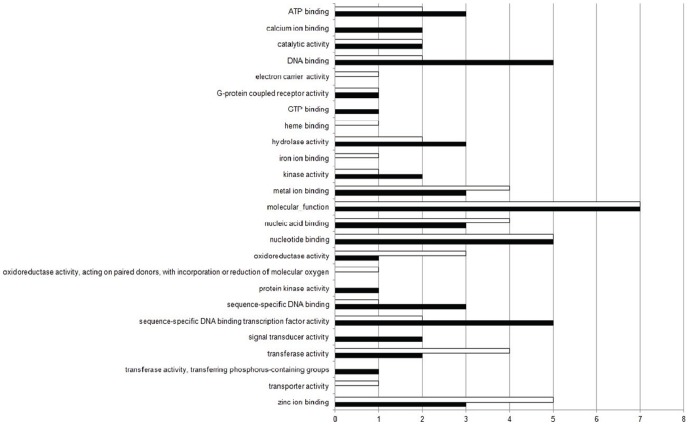
Comparison of Top20 GO terms found in the Molecular Function category.Percentage between the Top20 terms related to the down-regulated (black bars) and up-regulated genes (white bars), selected in the Molecular Function category.